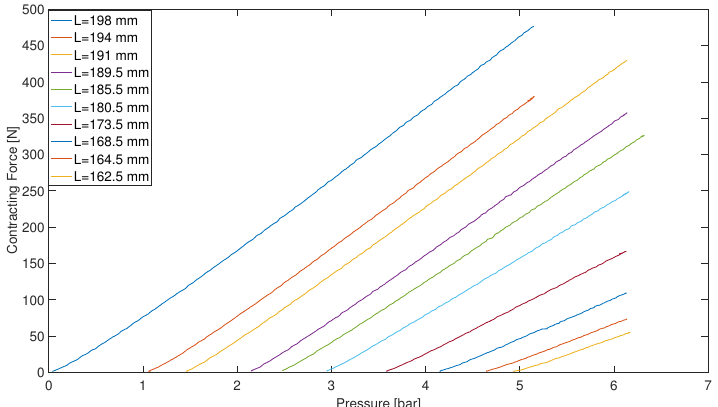
Figure 3. Static force f st vs. pressure at isometric conditions.